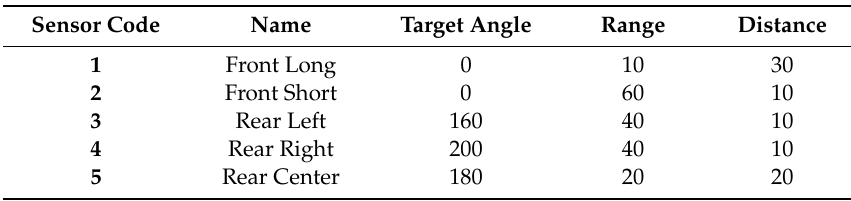
Table 2. Sensor Table 2. Sensor configuration.